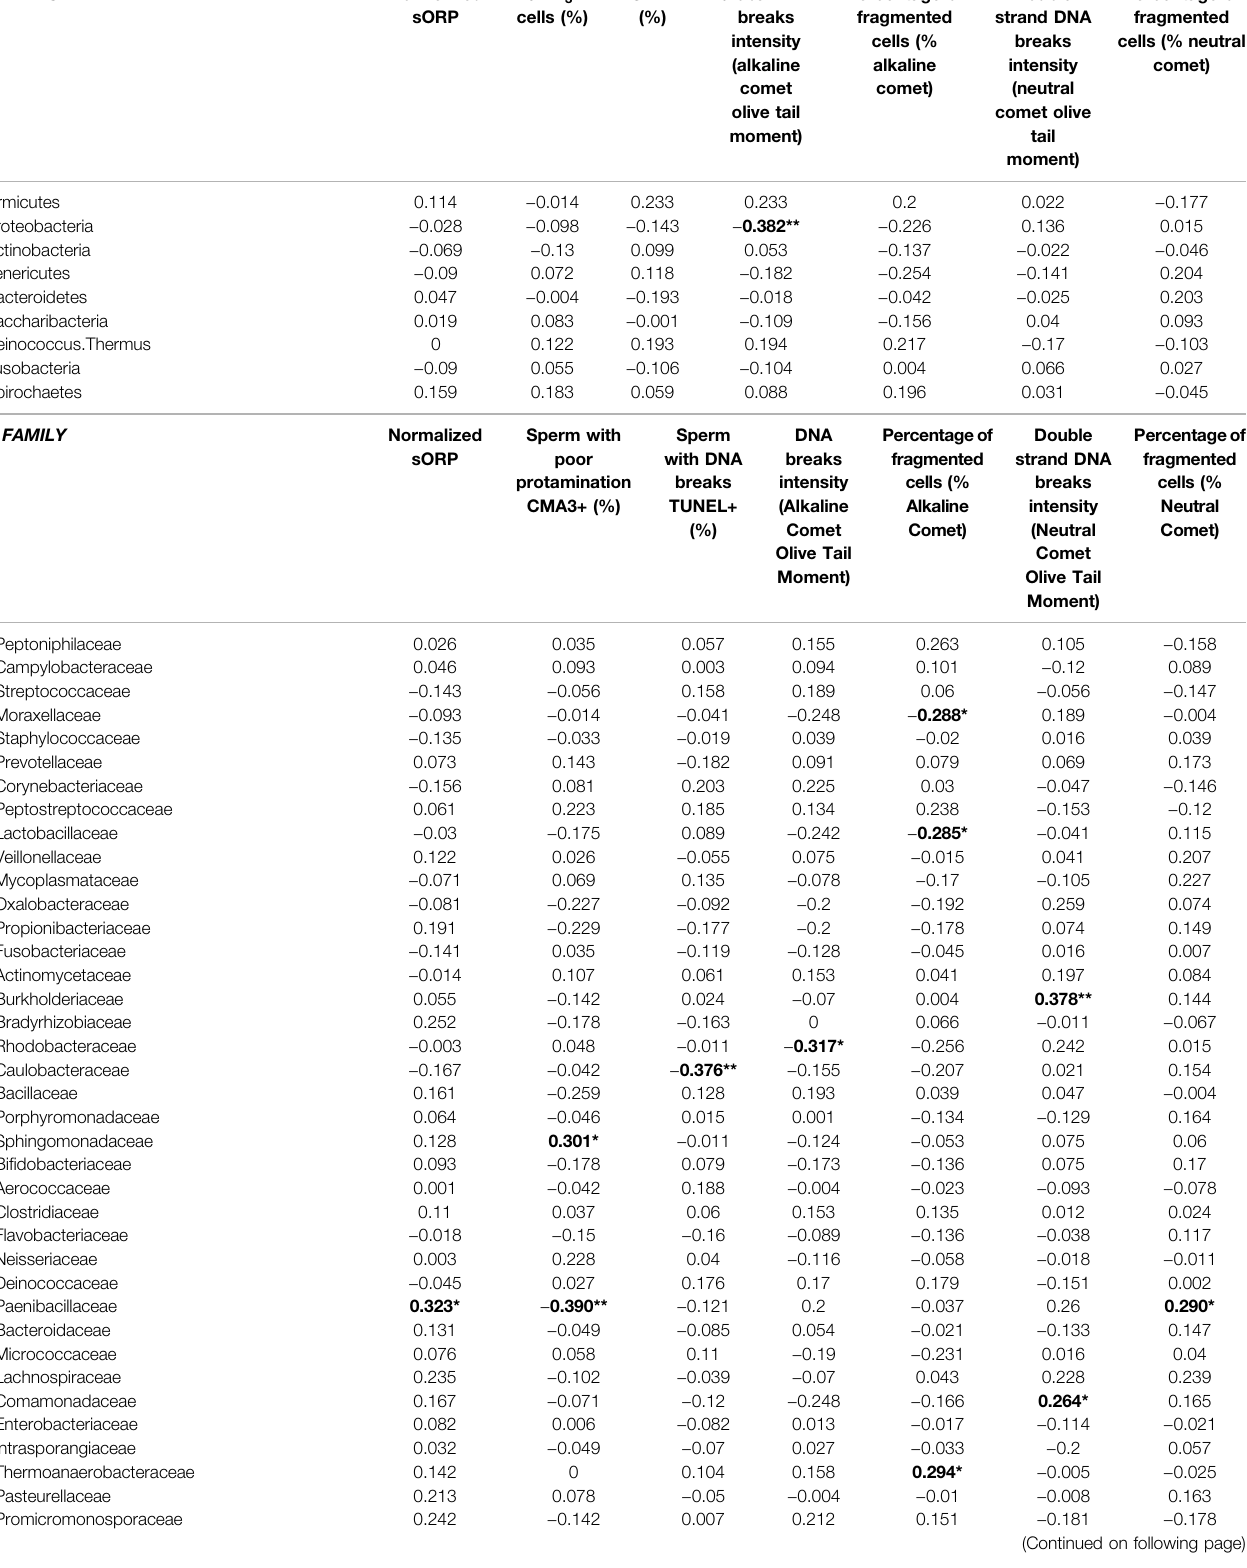
TABLE 5 | Correlation coef fi cients for the abundance of identi fi ed phylum, family or genera and oxidative stress and chromatin status. A